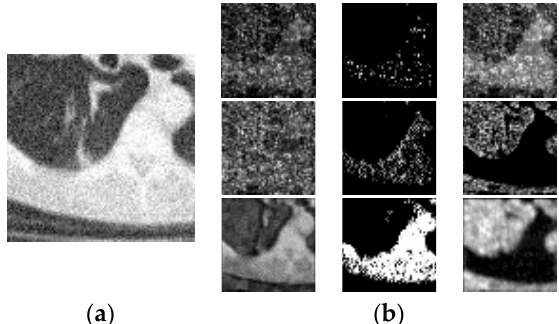
Figure 5. Visualization of feature maps extracted from the proposed noise estimation network when taking the noisy image as input. ( a ) is the input image patch, ( b ) are several feature maps as the visualization of the last short-cut connection layer (adding the last 1 × 1 convolutional layer and the input) of the third inception block of the proposed noise estimation network.